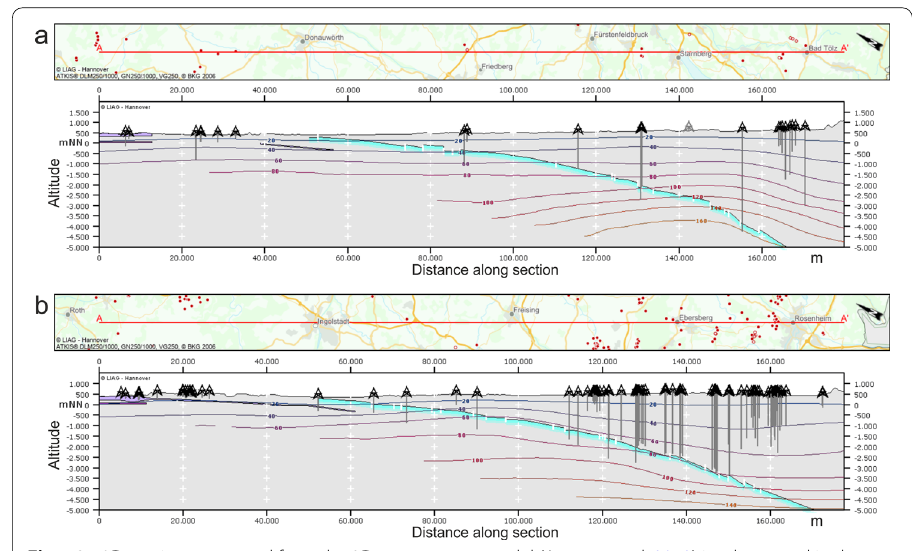
Fig. 18: 2D sections extracted from the 3D temperature model (Agemar et al. 2012) implemented in the Geothermal Information System GeotIS (Agemar et al. 2014; LIAG 2021), a being representative of the low Malm permeability known to the west of Munich, and b being representative of the high Malm permeability known in the Wasserburg Trough to the east of Munich. The section locations are indicated in the map slices above each 2D section and in Fig. 2. Full circles in the map slices and schematic drilling rigs with vertical drill paths in the 2D sections indicate boreholes with temperature information. Vertical exaggeration equals